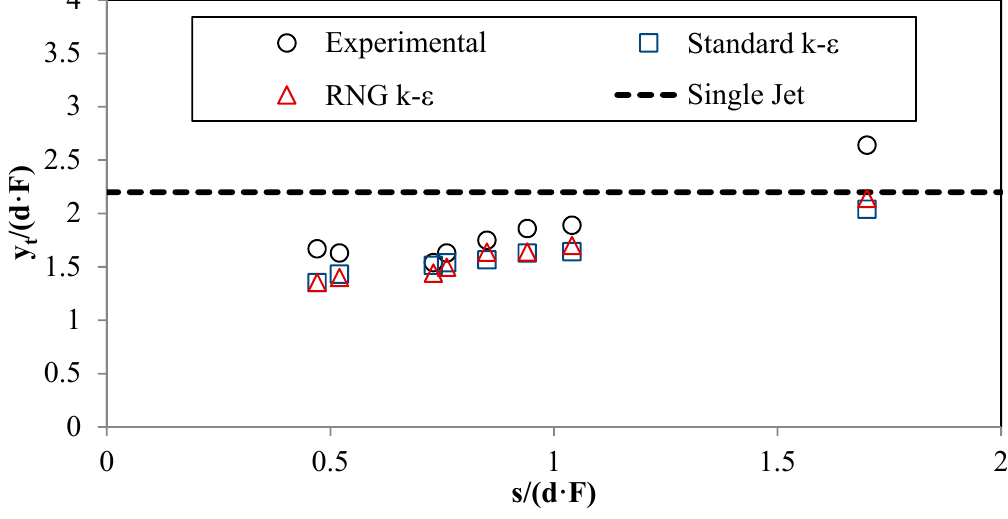
Table 2. Error indices of the numerical models for y t /( d · F ).